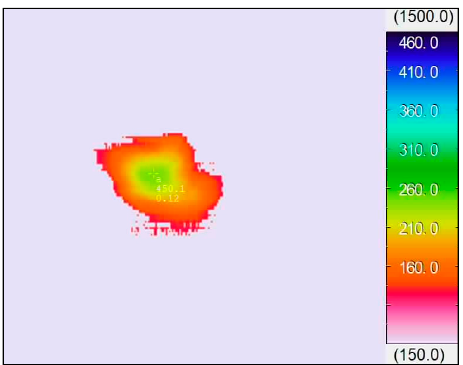
Figure 9. Cutting temperature distribution of chip with SCT1 at speed of 100 m/min in dry cutting hardened steels ( a p = 0.2 mm, f = 0.1 mm/r).